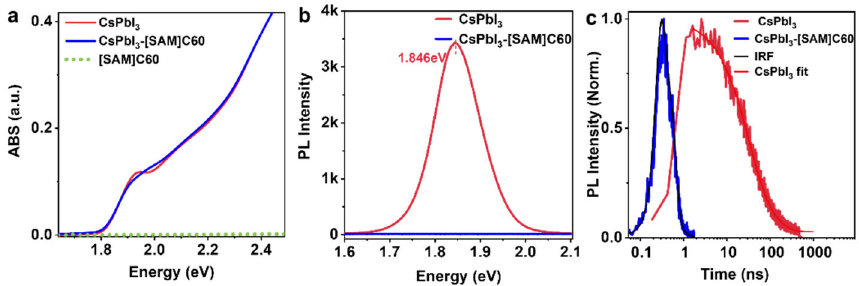
Figure 2. ( a ) Absorption spectra (ABS), ( b ) photoluminescence (PL), ( c ) time of resolved photolumi- nescence (TRPL) of CsPbI 3 QDs and CsPbI 3 -[SAM]C60 QDs.